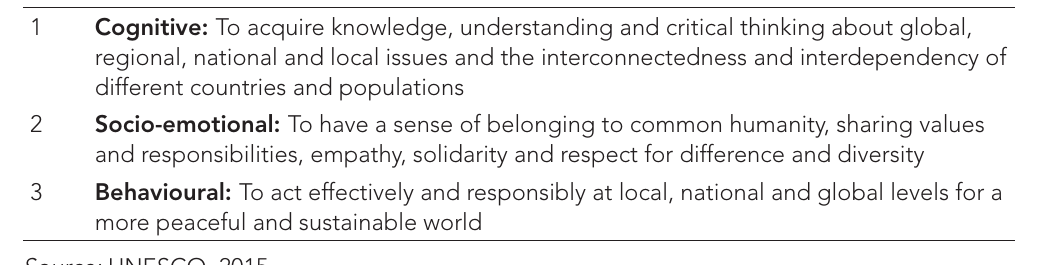
Table 1: UNESCO GCE core conceptual dimensions of